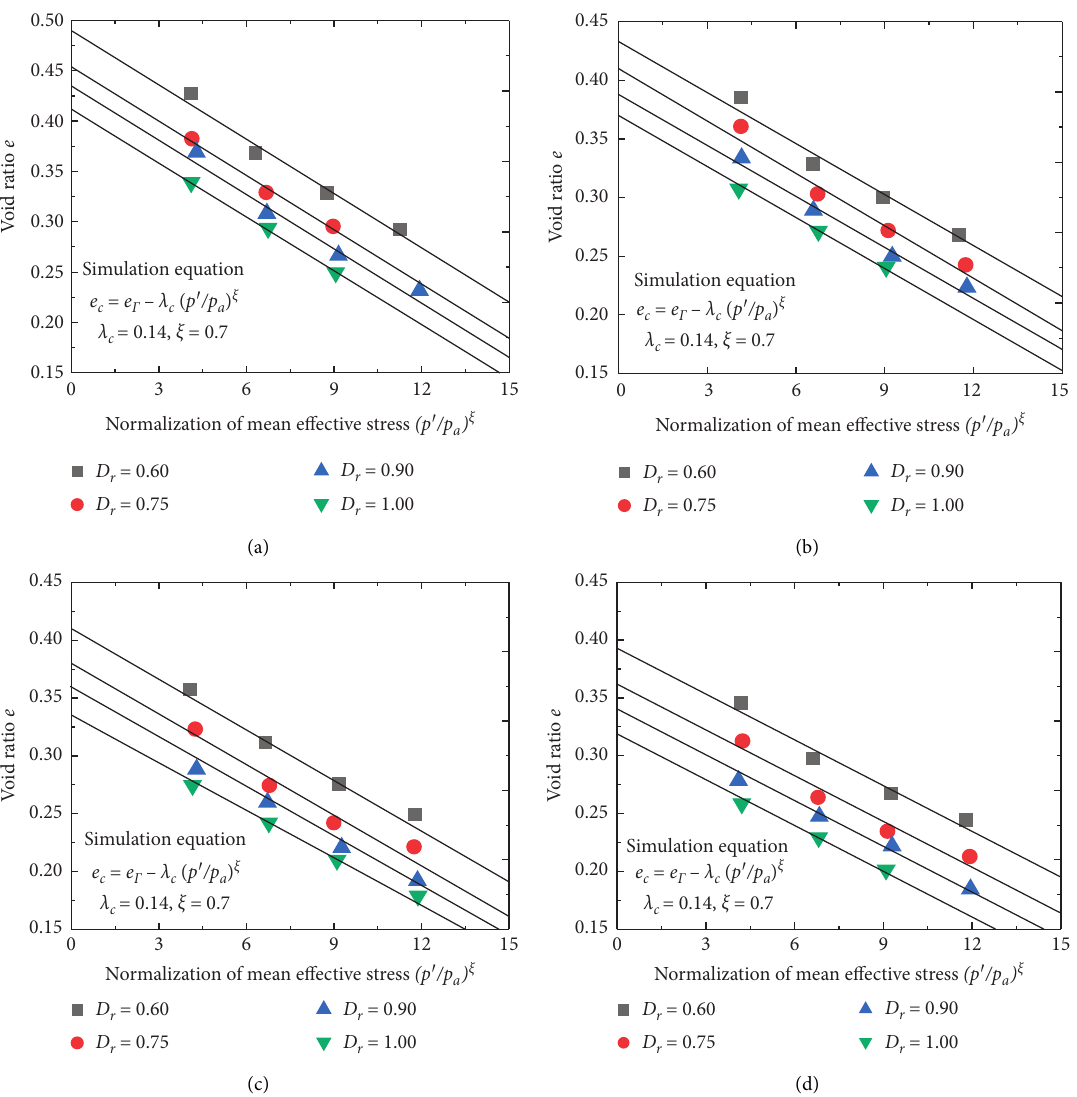
Figure 4: The critical state point and trend line in e ∼ ( p ′ / p 0.10.20.30.40.50.6